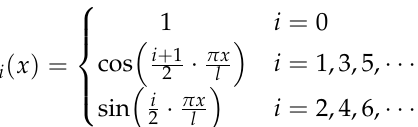
y E N V V P P Figure 5. Prediction mode based on the IELM during GPS outages. 5. Discussion 5.1. Simulation Test The proposed algorithm was simulated under the GPS/INS loosely coupled mode. The biases caused by drift and the random walk noise of the accelerometer were set as μ 100 g and μ 100